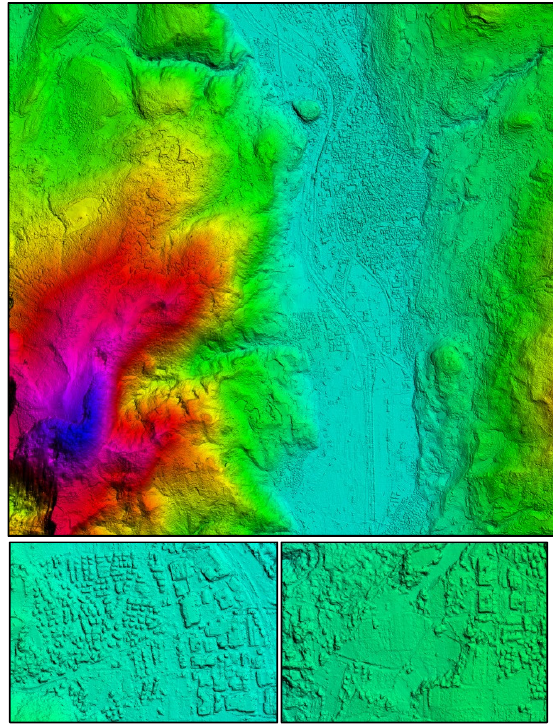
Figure 5. DSM from the GE1 stereo-pair. [Top] visualization in colour-shaded mode in SAT-PP software. [Bottom] zoom over Trento (left) and a steep rural area